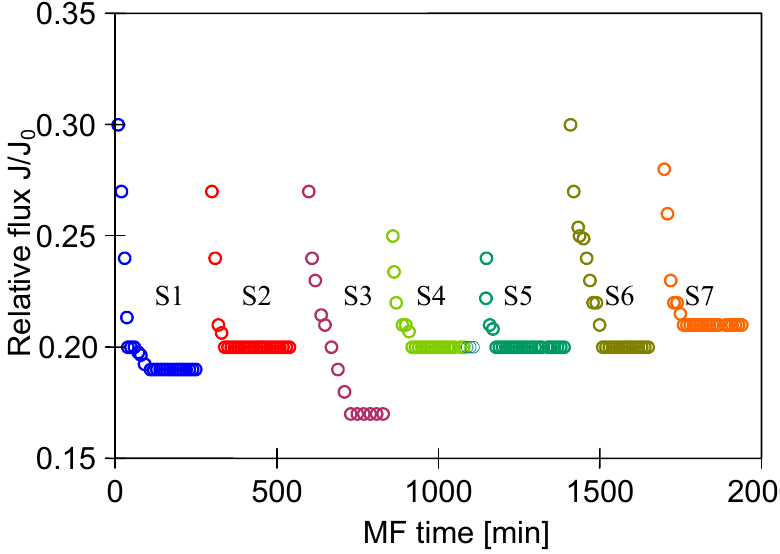
Figure 14. Changes in relative permeate flux during the long-term MF process of 1,3-PD fermenta- tion broth with Citrobacter freundii . Module M4, TMP = 0.02 MPa, V F = 5.5 m/s, CR—chemical